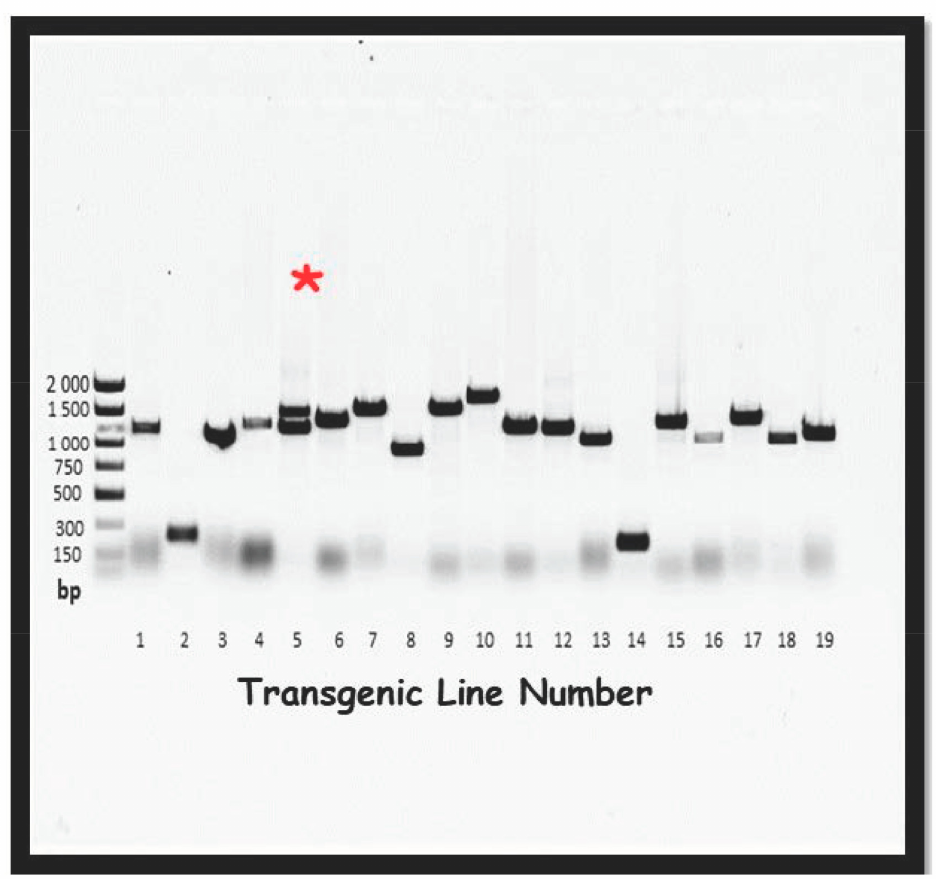
Figure 6. PCR amplification of FOX hunting FL-cDNAs from Malus sieversii (PI 613981) inserted into Arabidopsis . Note the distribution in the size of the inserts and that some lines have more than one insert. Line 5 is identified as an example of a line with multiple inserts